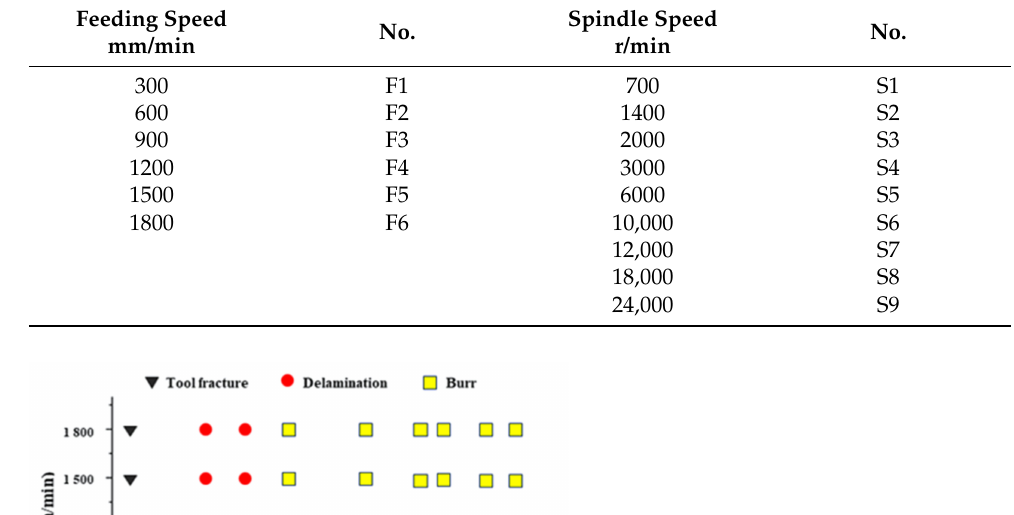
Table 1. Number of process parameters.